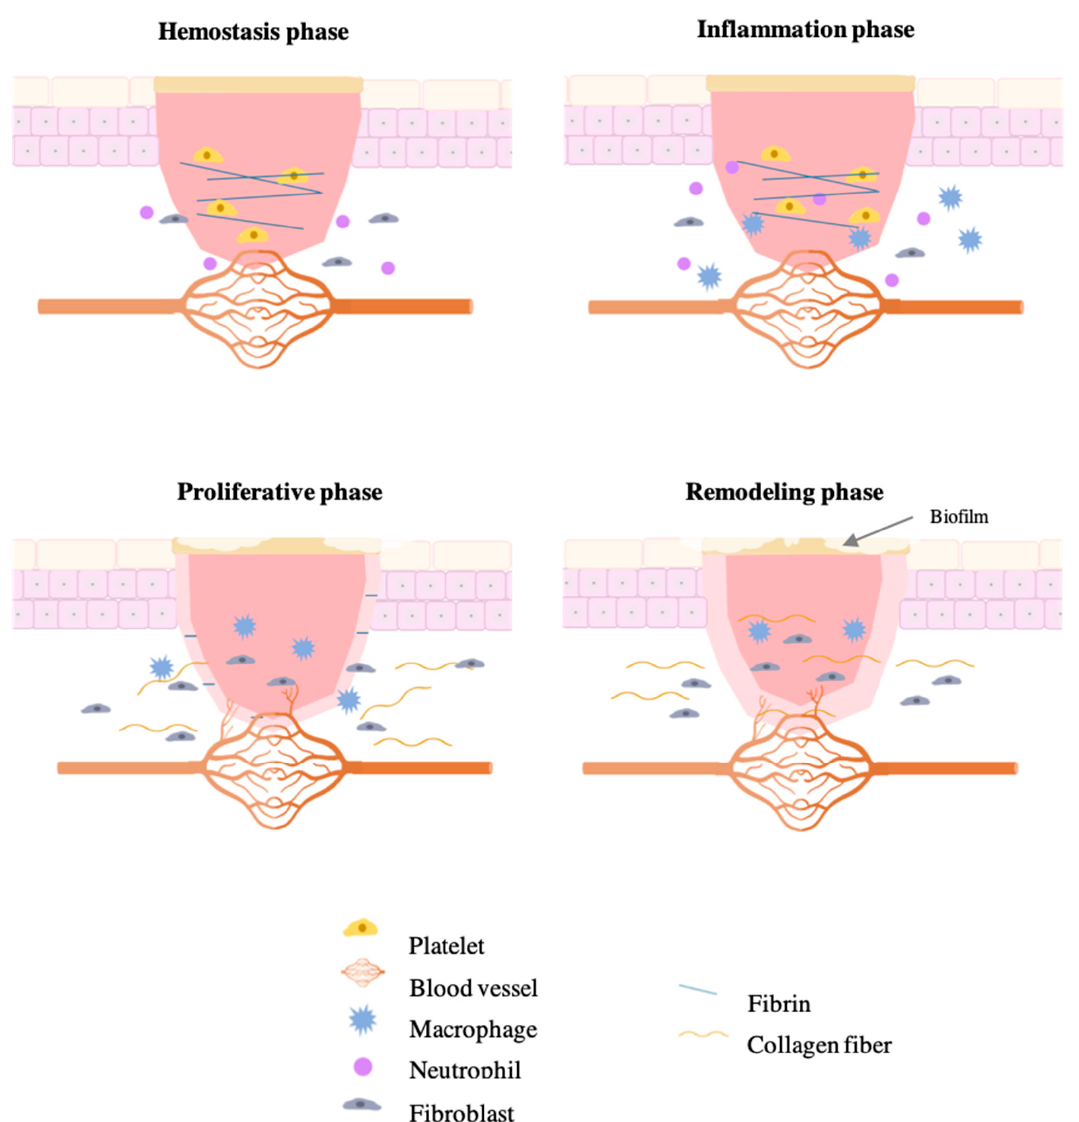
Figure 2. Different phases of impaired wound healing.